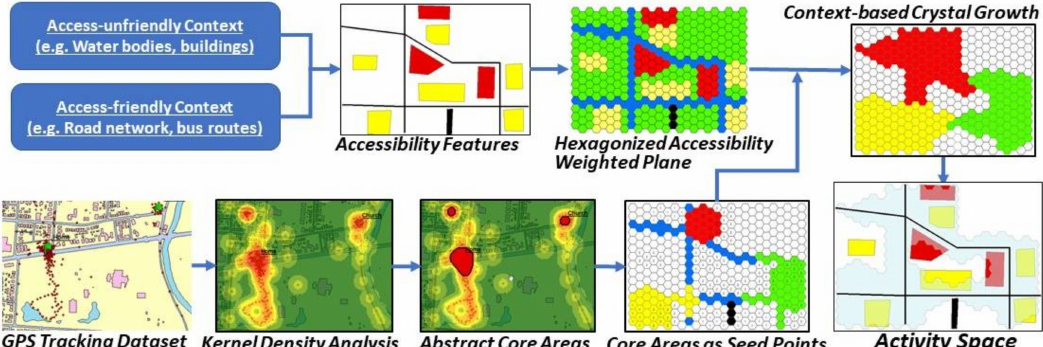
Figure 1. Workflow of the context-based crystal-growth activity space